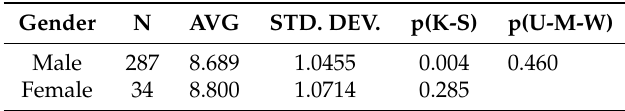
Table 3. Comparative study of learning between women and men. Gender N AVG STD. DEV.